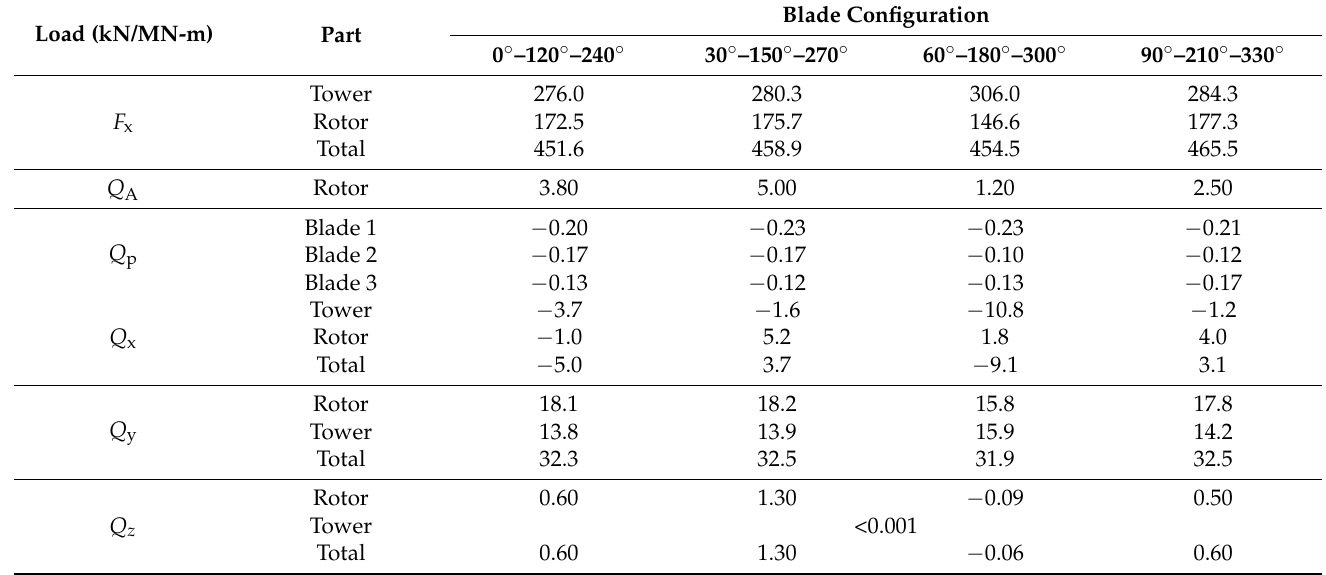
Table 5. Wind loads under steady extreme wind.